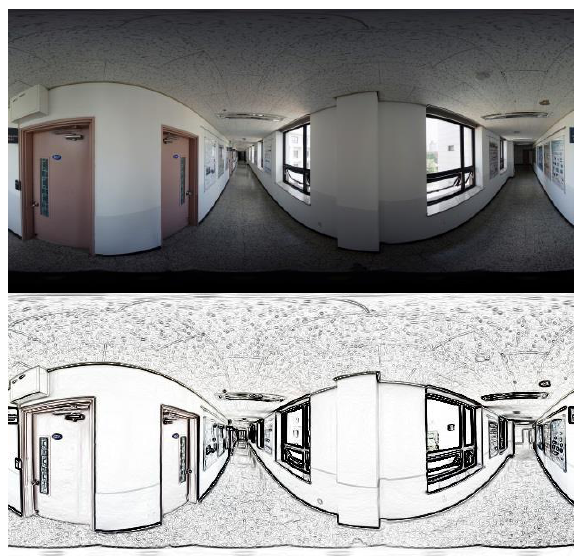
Figure 2. Adoption the edge detection on the omni-directional image (top: original, bottom: result)